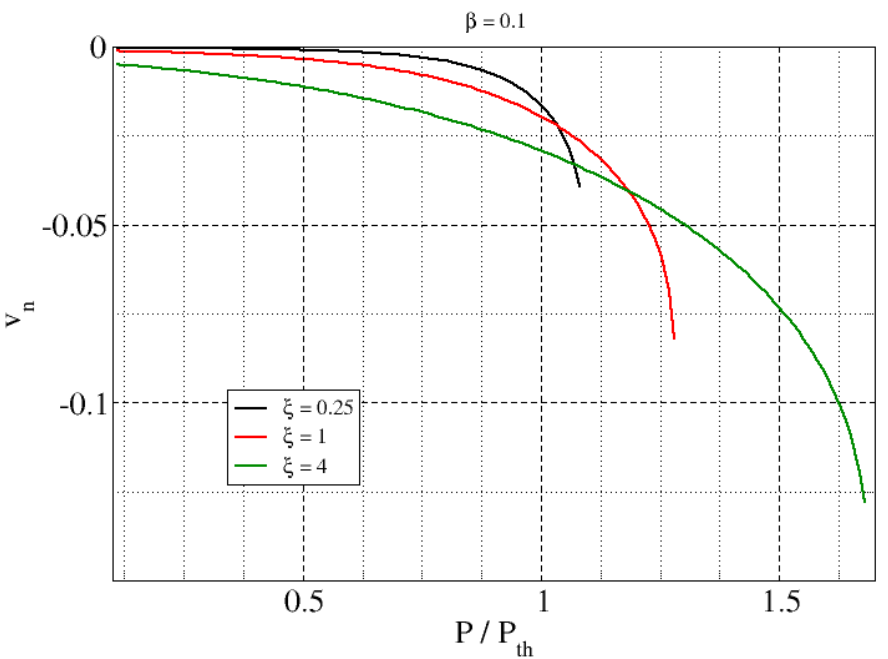
Figure 11. Normalized photon component v n of the least stable eigenvector (matching the least stable eigenvalue in Figure 10) for different kinds of asymmetry in the emission rates. Each curve stops at the point where the eigenvector becomes complex, simultaneously with the appearance of an imaginary component in the corresponding eigenvalue. β = 10 − 1